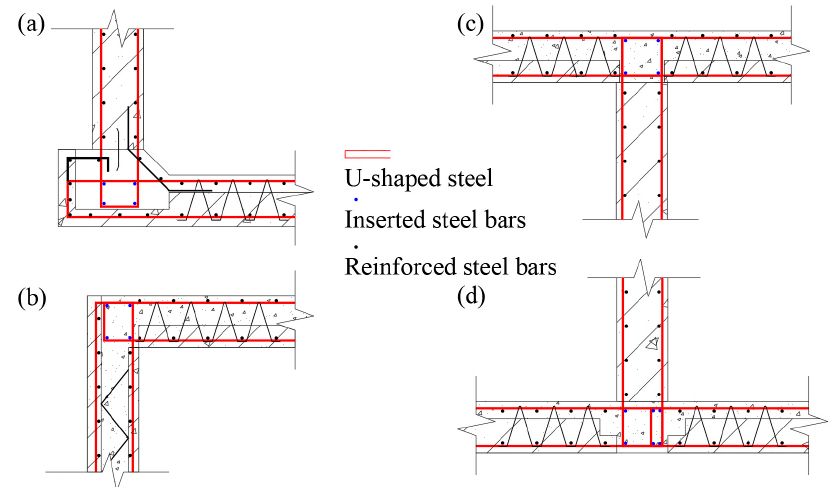
Figure A1. Four kinds of joint connections: ( a ) between lateral wall and top plate; ( b ) between lateral wall and bottom plate; ( c ) between middle wall and top plate; and ( d ) between middle wall and bottom plate. The longitudinal connections of the prefabricated utility tunnel are mainly divided into four kinds: between bottom plates, between top plates, between lateral walls, and between middle walls, which are shown in Figure A2.